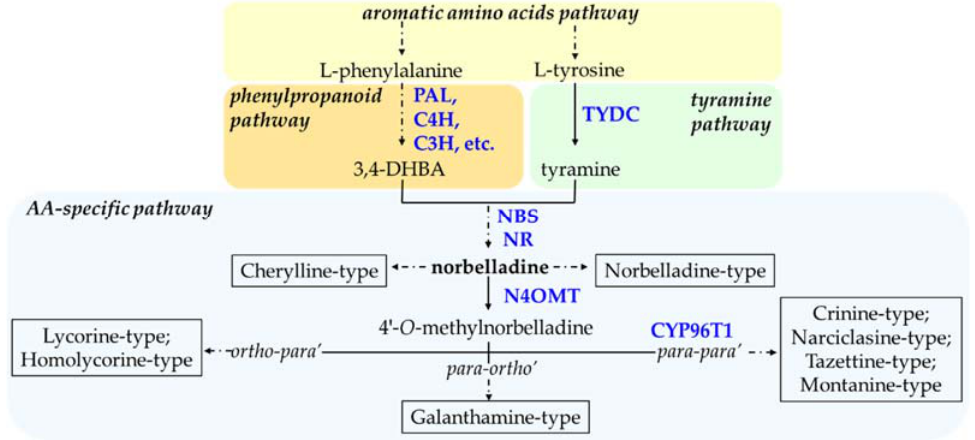
Figure 2. Biosynthetic routes to main types (boxed) of Amaryllidaceae alkaloid (AA). Arrows without labeling reflect chemical reactions where no enzyme was characterized. Enzymes that have been identified are labeled in blue. A solid arrow shows one enzymatic step, whereas a broken arrow symbolizes multiple enzymatic reactions. Following 4’ O ‐ methylnorbelladine, the regioselective phenol-phenol ’ coupling reaction is indicated in the broken arrow, leading to various AA-types. Enzyme abbreviations: 3,4-DHBA, 3,4-dihydroxybenzaldehyde; PAL, phenylalanine